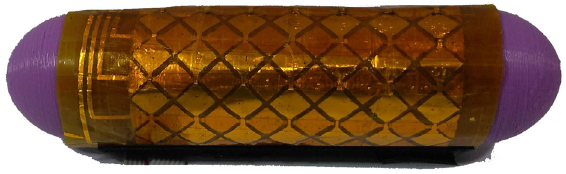
Figure 20: The fl exible touch - sensitive sensor can be applied for recognizing gestures in vibrators and other sex toys.